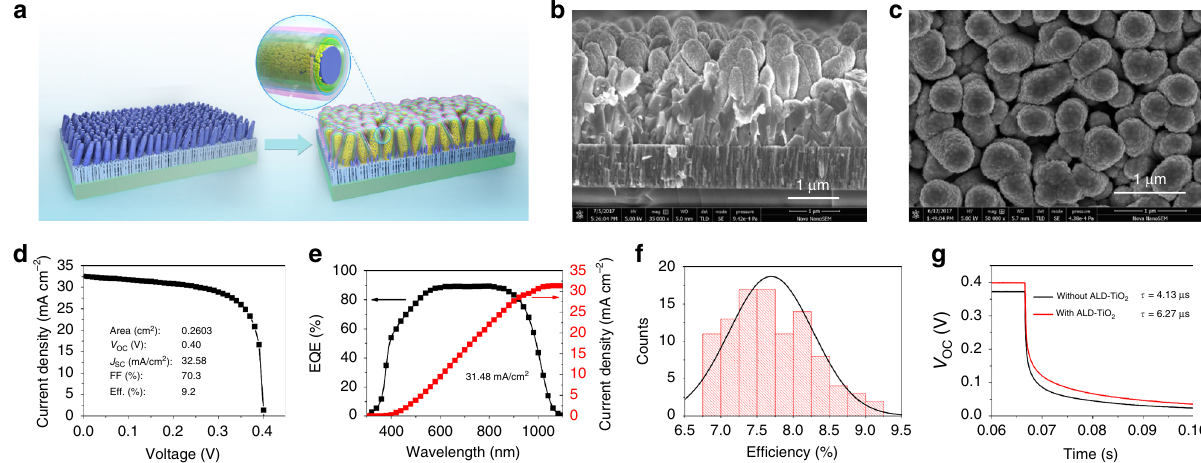
Fig. 6 Solar cell structure and mechanistic investigation of ALD-TiO 2 on Sb 2 Se 3 nanorod arrays. a Schematic of the Sb 2 Se 3 nanorod arrays on Mo-coated glass and fi nished Sb 2 Se 3 /CdS core/shell nanorod array solar cells. b , c Cross-sectional ( b ) and top view ( c ) SEM images of the completed CdS/Sb 2 Se 3 solar cells. d , e J-V curve ( d ) and EQE spectrum ( e ) of the champion device (area = 0.2603 cm 2 ). f Histogram of device ef fi ciency over 100 individually fabricated solar cells. g V OC decay curves of the solar cells with and without ALD-TiO 2 layer